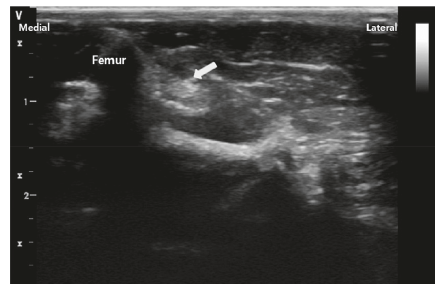
Figure 1: Ultrasound image of sciatic nerve